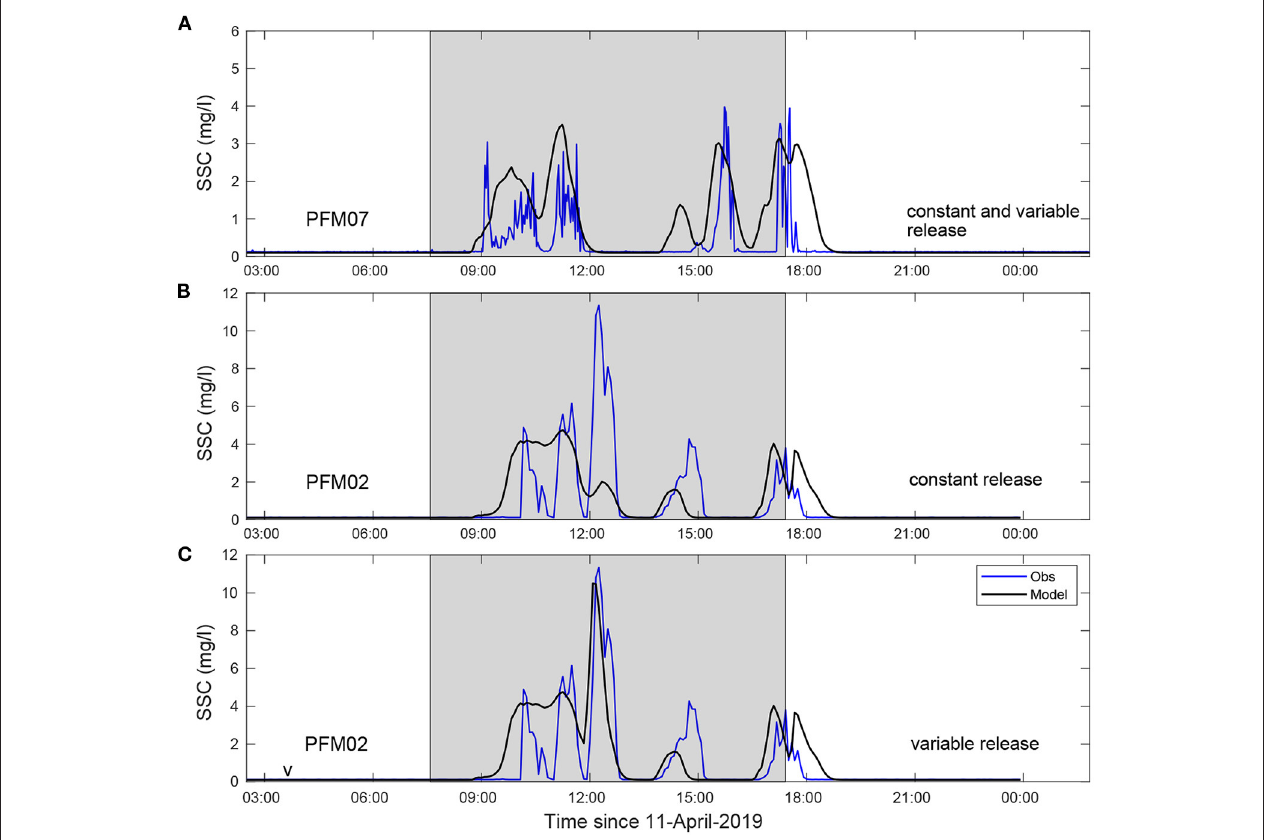
FIGURE 4 | Comparison of observations and modeled SSC at (A) station PFM07 and (B) station PFM02 with a constant release, and at (C) station PFM02 with a variable release. The time interval when dredging was carried out is marked in grey. Observation and model results are shown by the blue and black lines in each graph,